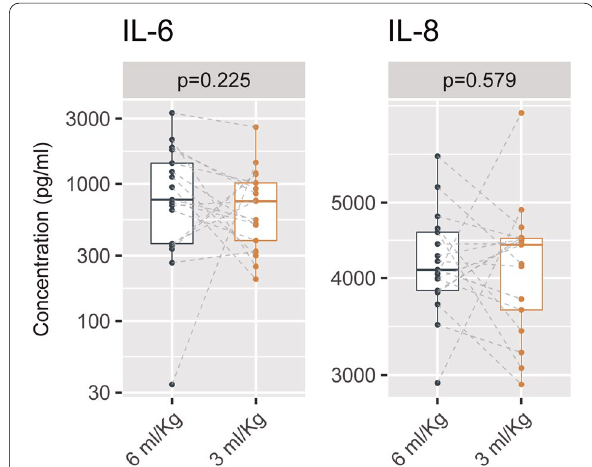
Fig. 2 Concentration of IL‑6 and IL‑8 in bronchoalveolar lavage fluid during ventilation with a tidal volume of 6 ml/kg PBW or 3 ml/ kg PBW. Dots and dashed lines show the individual values for each patient. Y ‑axis is traced using a logarithmic scale. The lower and upper hinges correspond to the first and third quartiles (the 25th and 75th percentiles). The upper and lower whiskers extend from the hinge to the largest or smallest value no further than 1.5 times the interquartile range from the hinge. Individual values are shown as points. Values for a given patient are connected by dashed lines. P values were obtained using a Wilcoxon test for paired data. PBW predicted body weight, IL interleukin